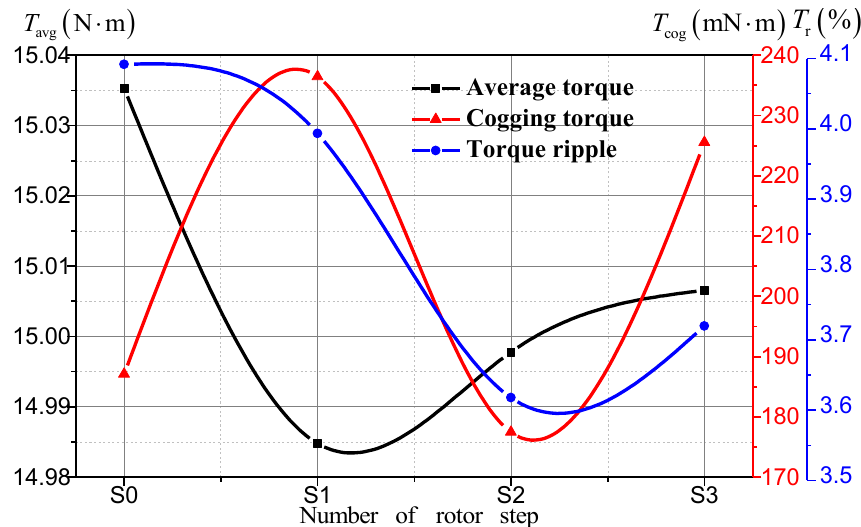
Figure 8. Average torques, torque ripples, cogging torques according to the number of rotor